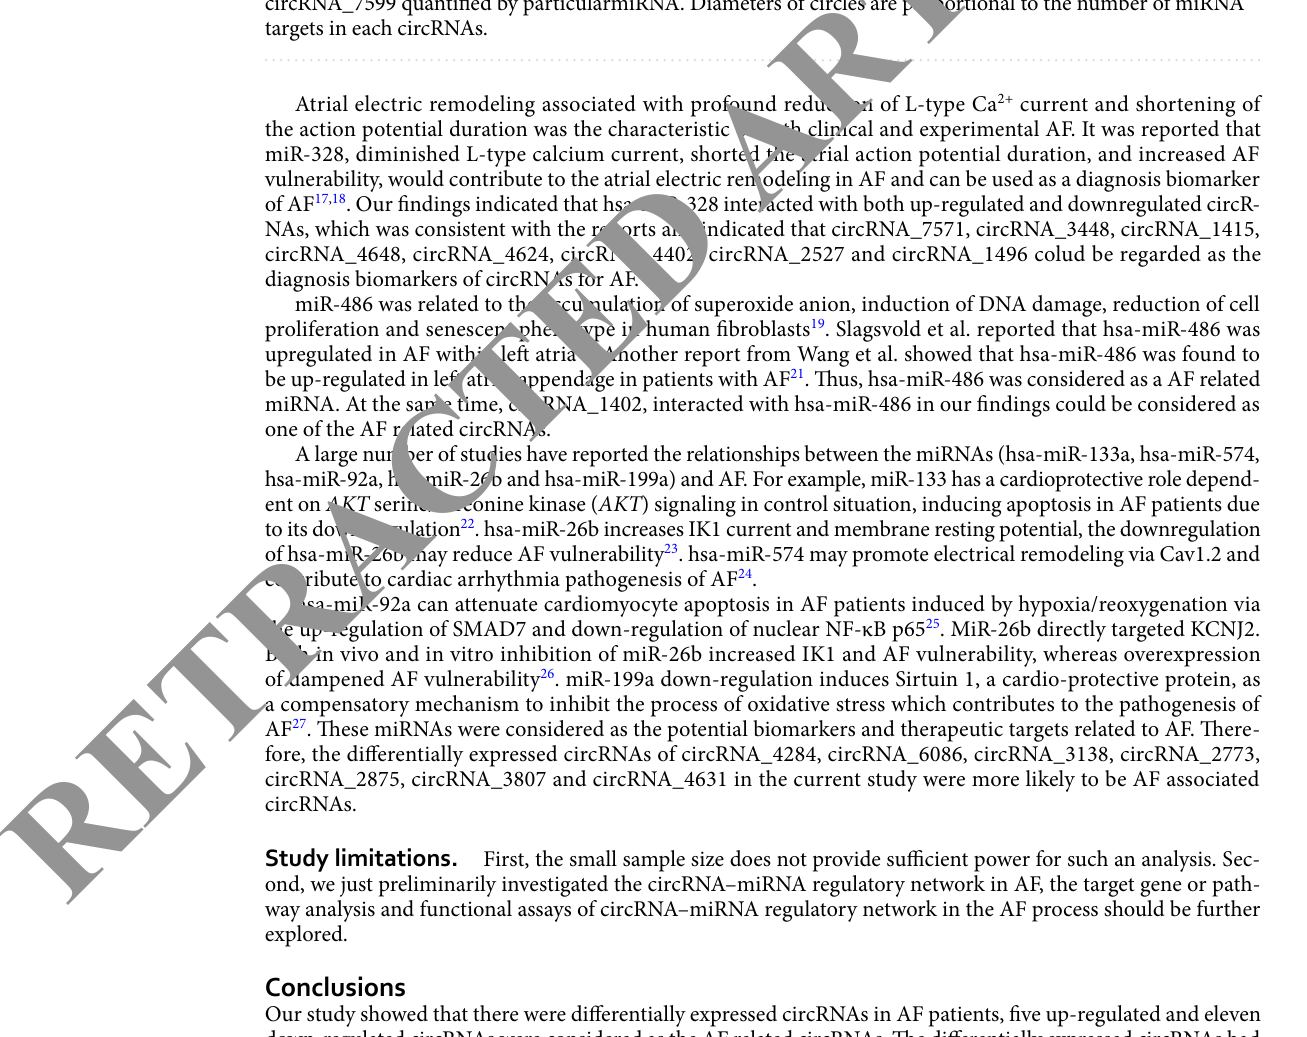
Figure 4. Sponging capabilities of circRNA_7571, circRNA_4648, circRNA_4631, circRNA_2875and circRNA_7599 quantified by particularmiRNA. Diameters of circles are proportional to the number of miRNA targets in each